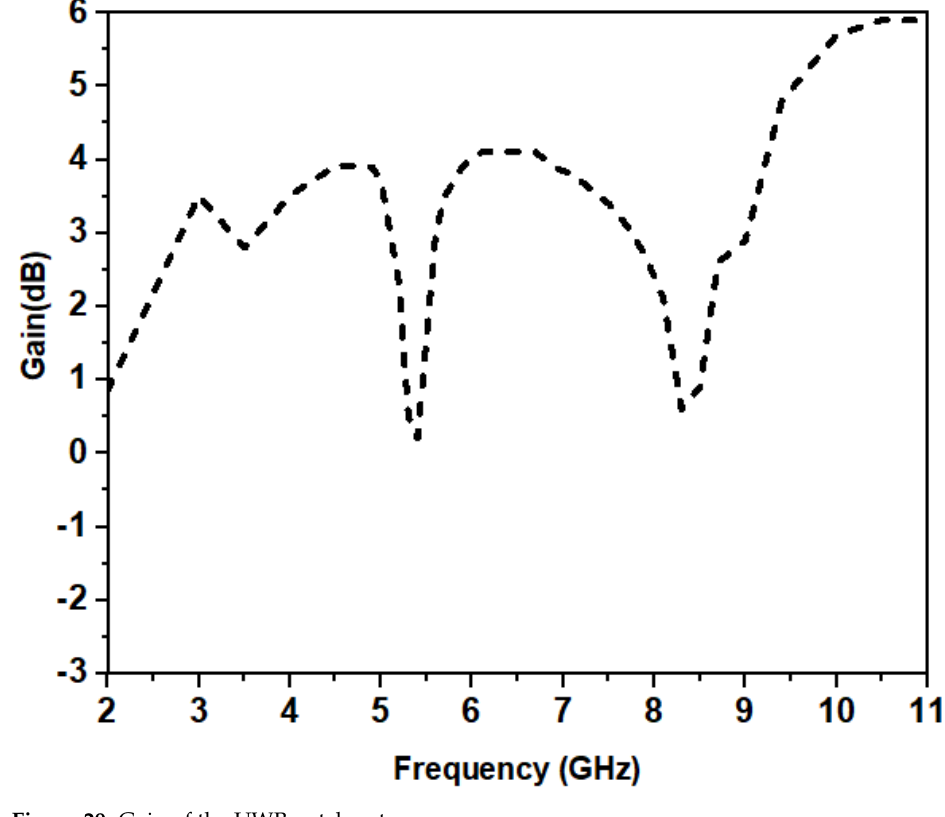
Figure 29. Gain of the UWB notch antenna.